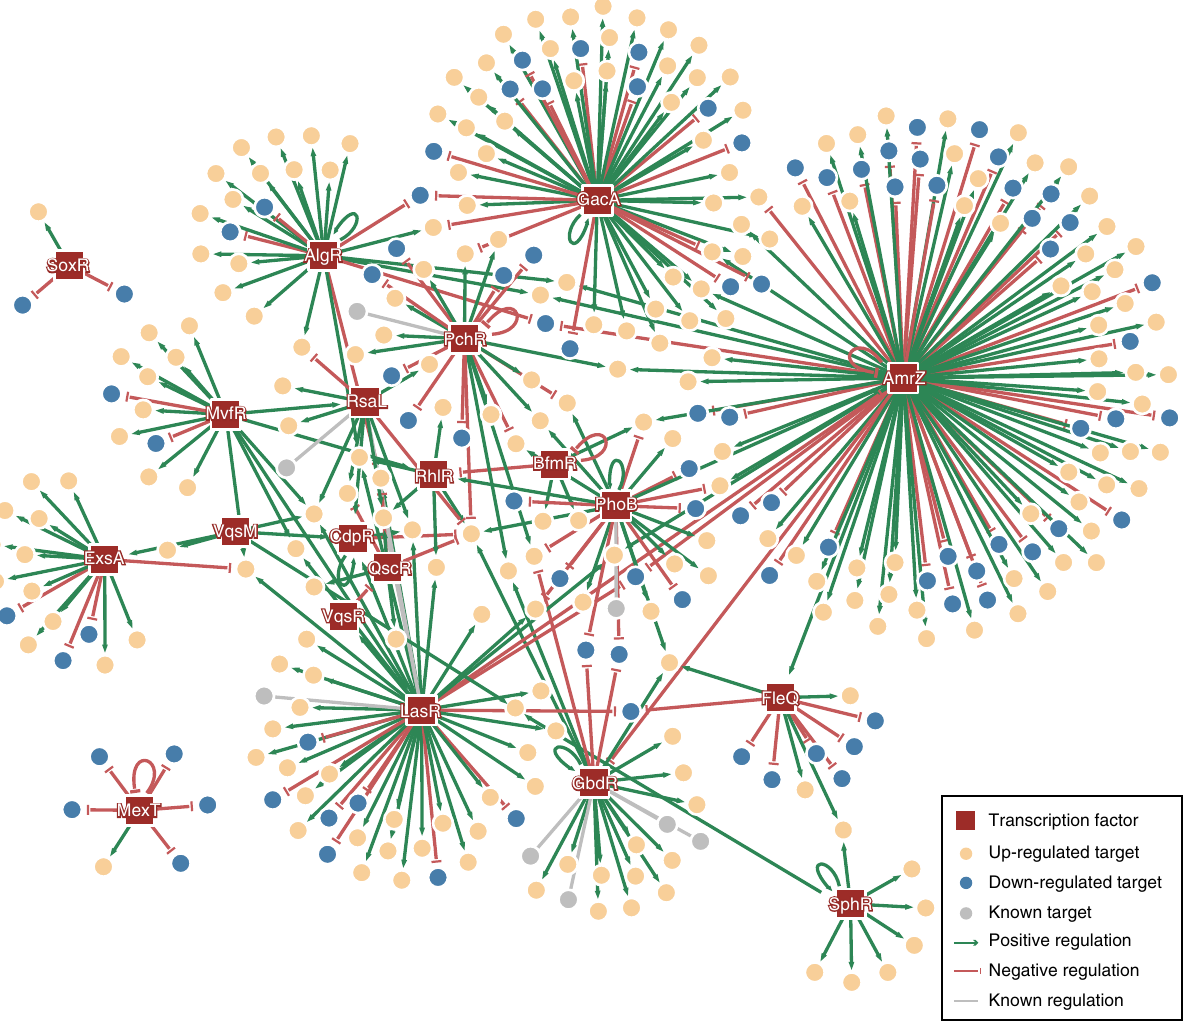
Fig. 4 Visualization of the PAGnet. PAGnet is established by integrated twenty Pseudomonas aeruginosa transcriptional factors regulons. The rectangle represents 20 genomic transcription factors, and the circle represents the functional targets of different transcription factors. Among these targets, the orange targets are positively regulated by the transcription factor, the blue ones are negatively regulated by the transcription factors, and the grey ones represent regulatory relationship is unknown. The target can be co-regulated by multiple transcription factors, and some TFs have